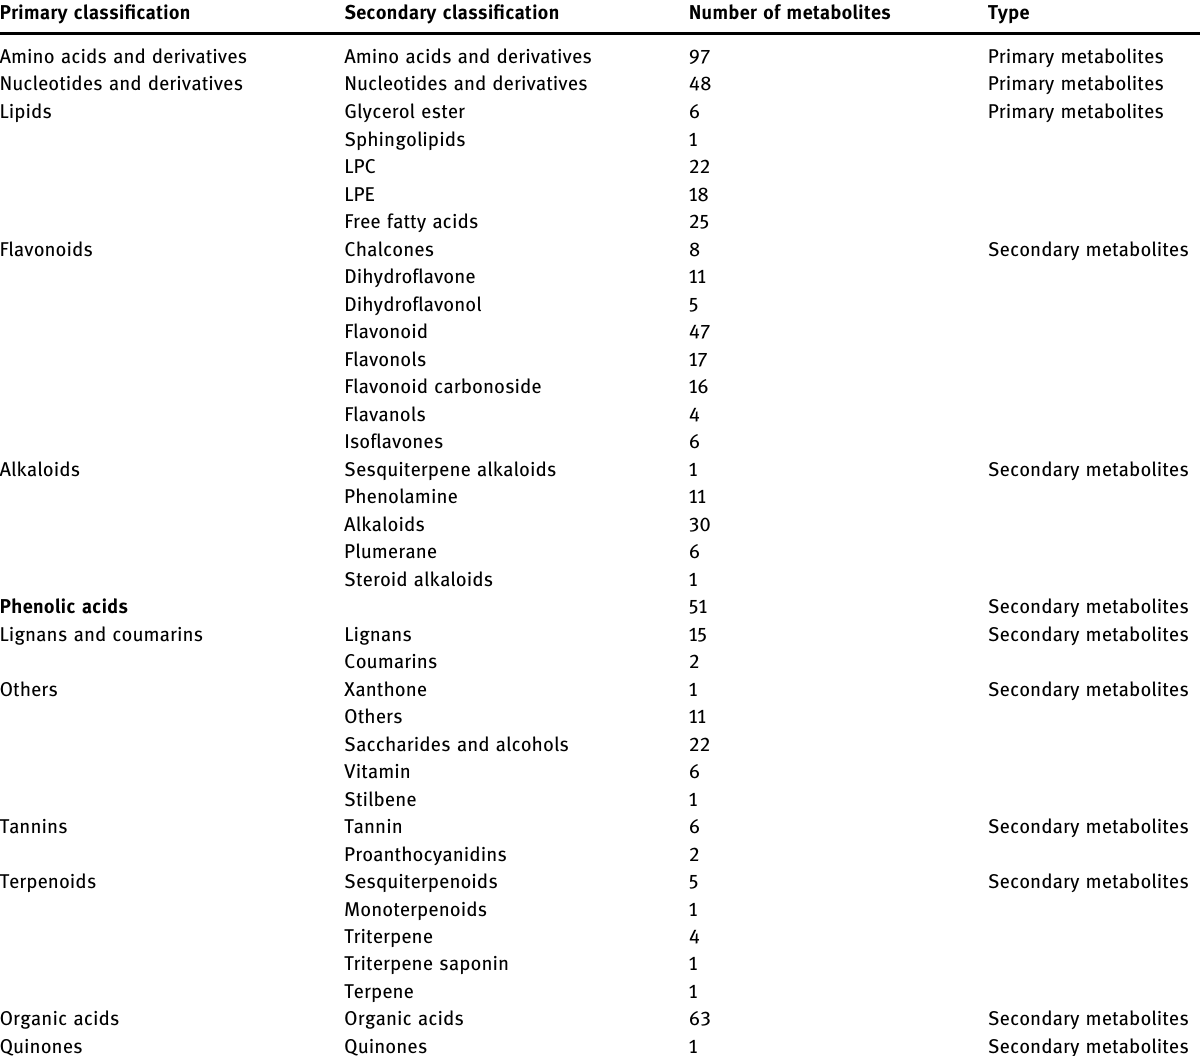
Table 1: Overview of the identi fi ed metabolites in Pinelliae rhizome Primary classi fi